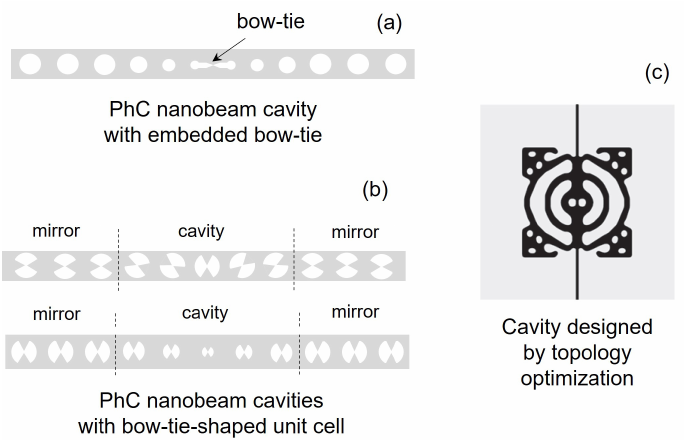
Figure 15. Cavities for extreme dielectric confinement (EDC). EDC cavities realized ( a ) by embed- ding a bow-tie in a PhC nanobeam cavity [9] and ( b ) through sub-wavelength engineering with a bow-tie shape of the unit cell of a PhC nanobeam [8,113]. ( c ) EDC cavity designed by topology optimization [10]. In Figure 15c, the gray area is air and the black area is semiconductor. Figure 15c is reprinted from [10], with the permission of AIP publishing,